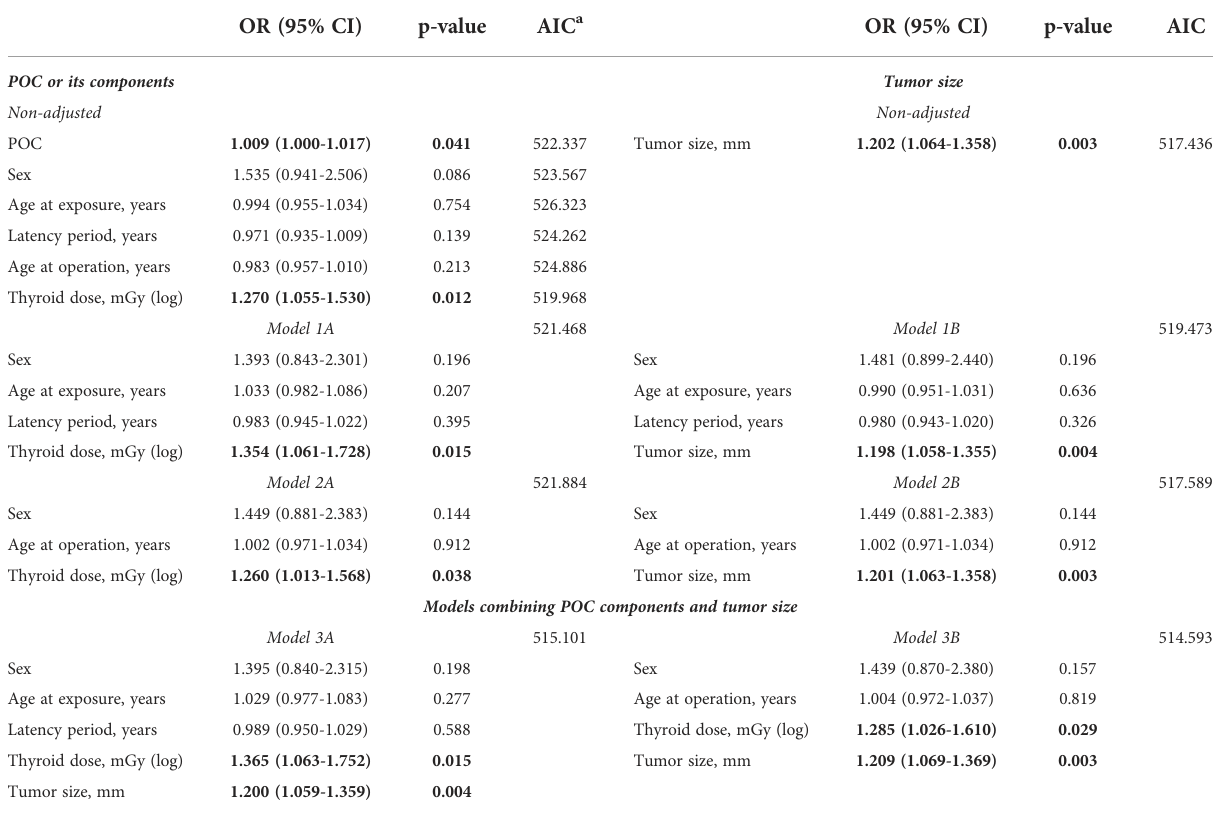
TABLE 4 Effects of thyroid dose and tumor size on lymphovascular